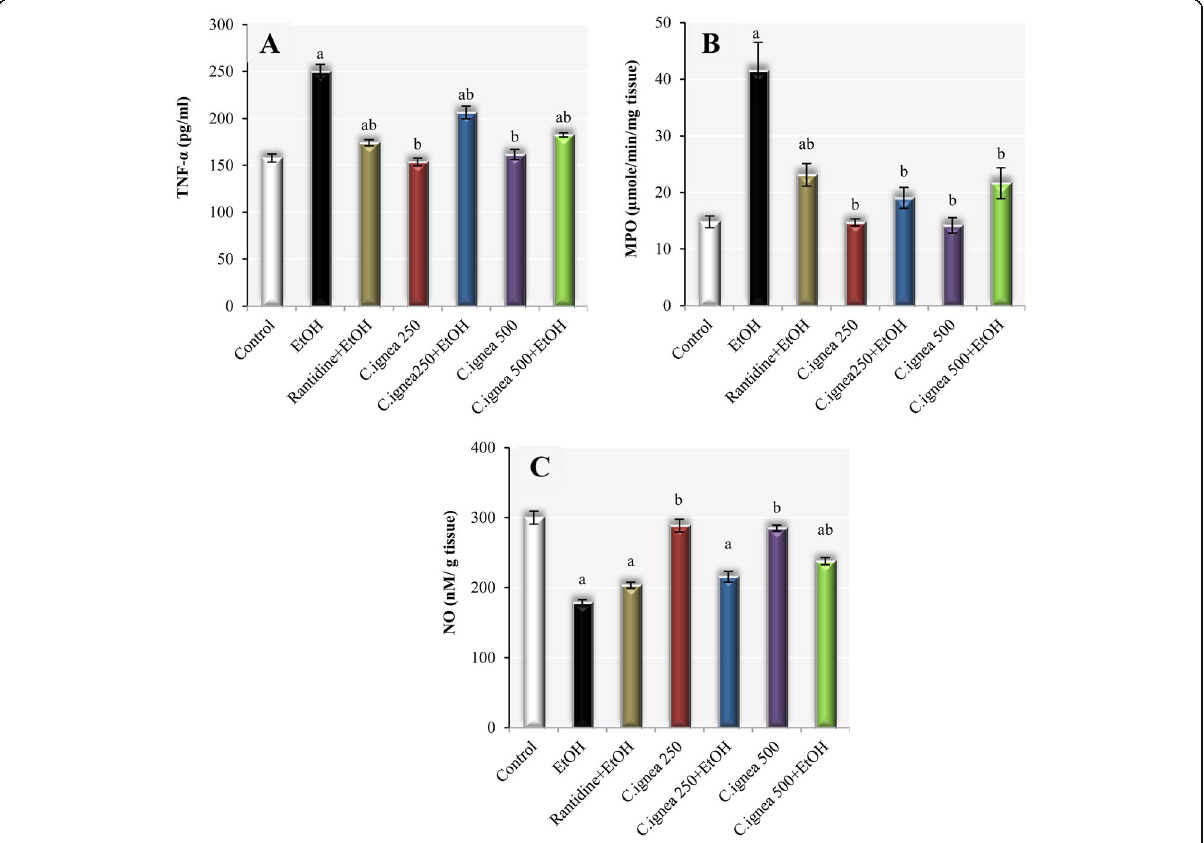
Fig. 4 Effect of C. ignea aerial parts extract on ( a ): serum TNF- α , ( b ): gastric MPO and ( c ): gastric NO in various experimental groups. Each value represents the mean ± SD for six rats in each group. Statistically significant difference is expressed at p <0.05. a significantly different from normal control group, b significantly different from ethanol